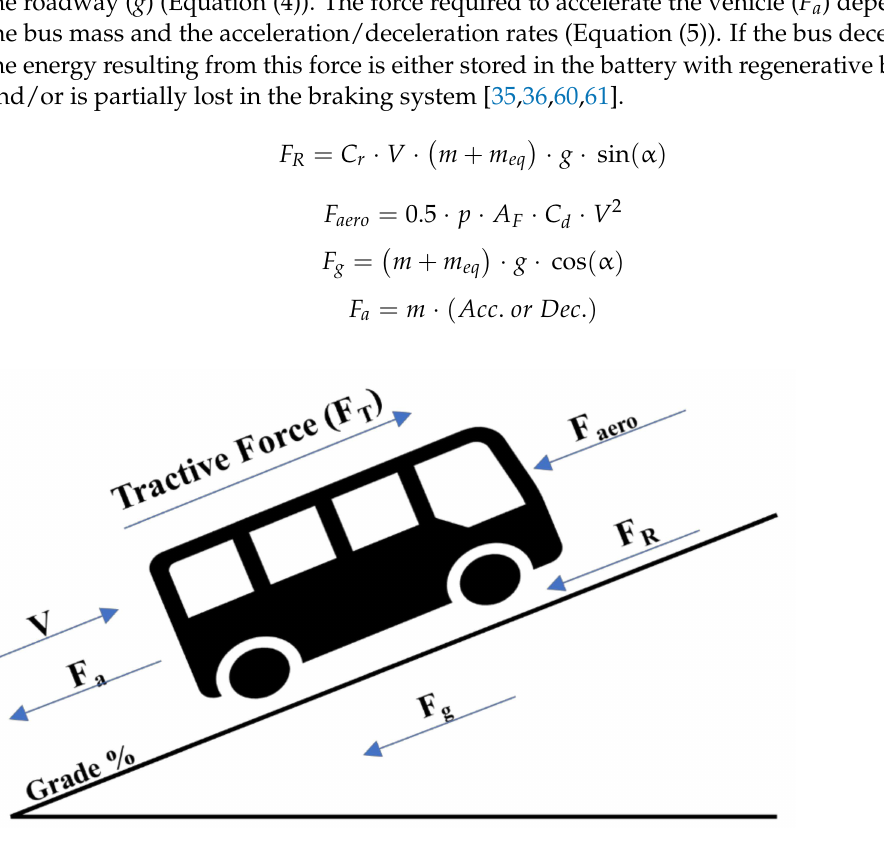
Figure 4. The longitudinal forces acting on the bus